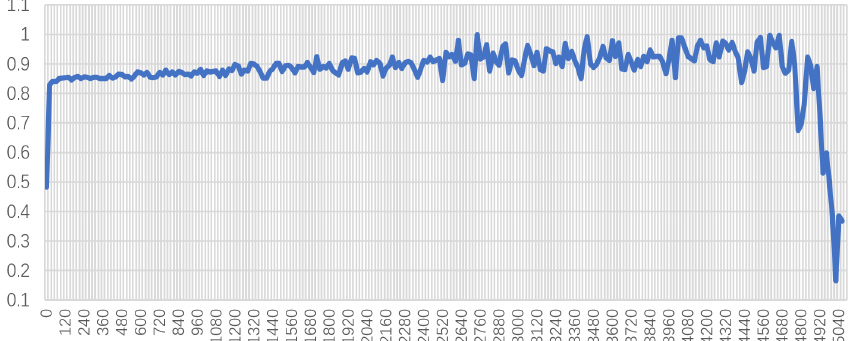
Figure 7. The encoded accuracy with different numbers of hidden layer units in ELM. It can be seen that the accuracy gradually improves up to the level of 1800 hidden neurons. However, when the number of neurons exceeds 4700, the model will have large errors and its performance will drop sharply.